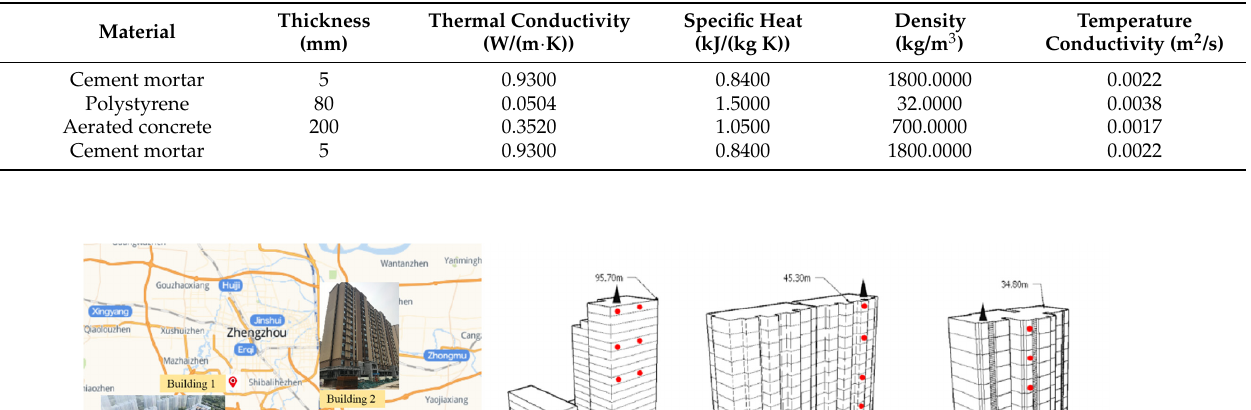
Table 1. Details of the three buildings.